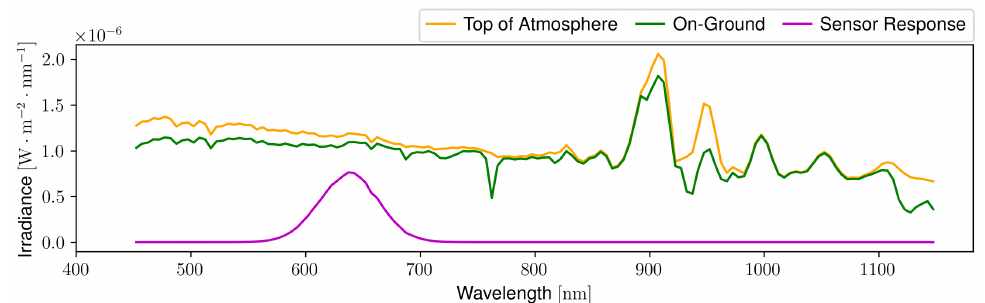
Figure 6. Conversion of satellite reflectance spectra to instrument